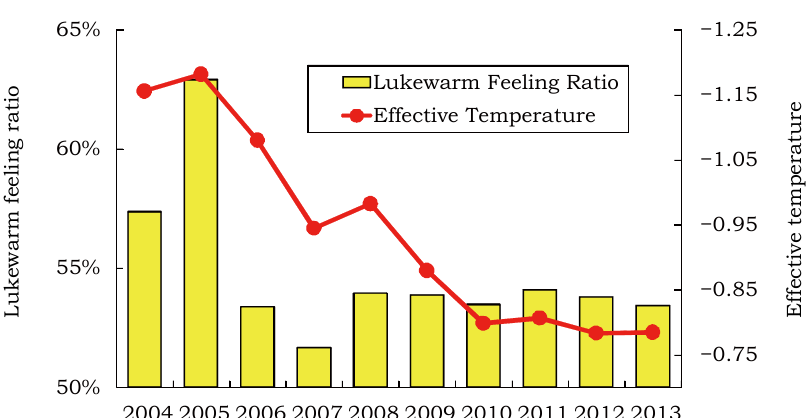
Figure 2. Transition in lukewarm feeling ratio and effective temperature (Survey